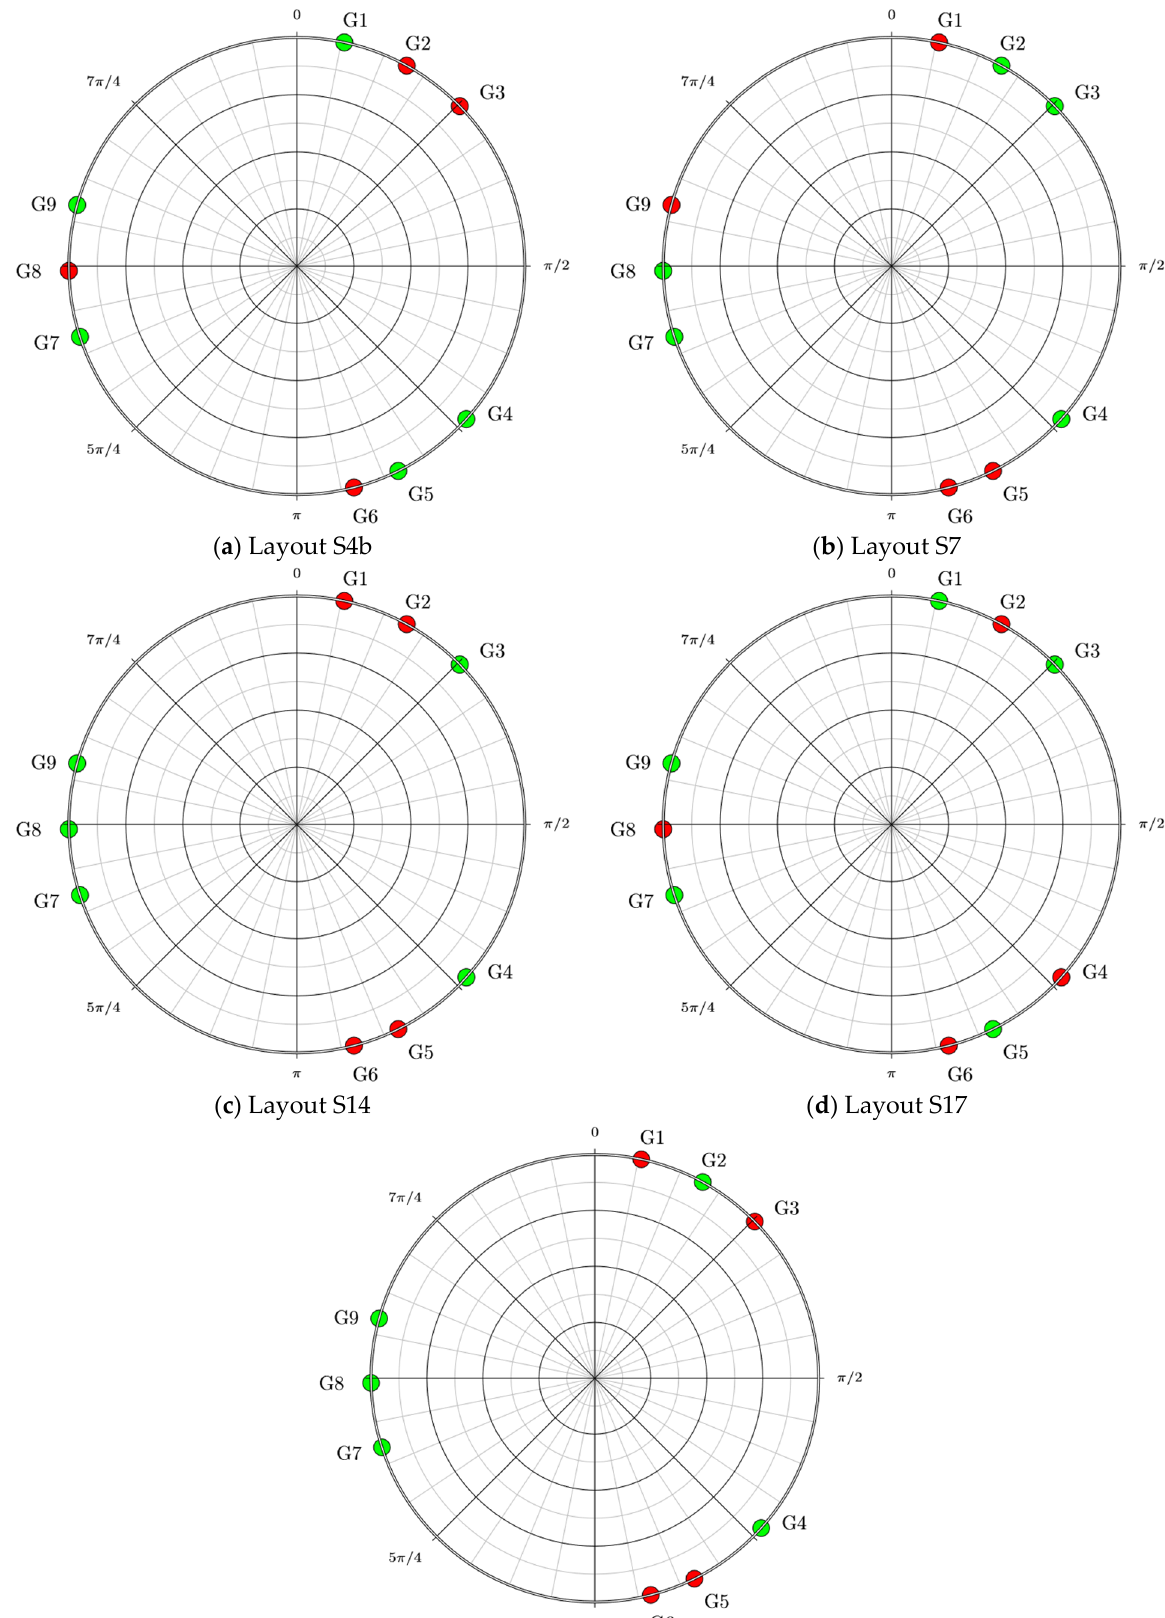
Figure 5. Analyzed layouts. Red points identify the position of control sensors while green points those of reference